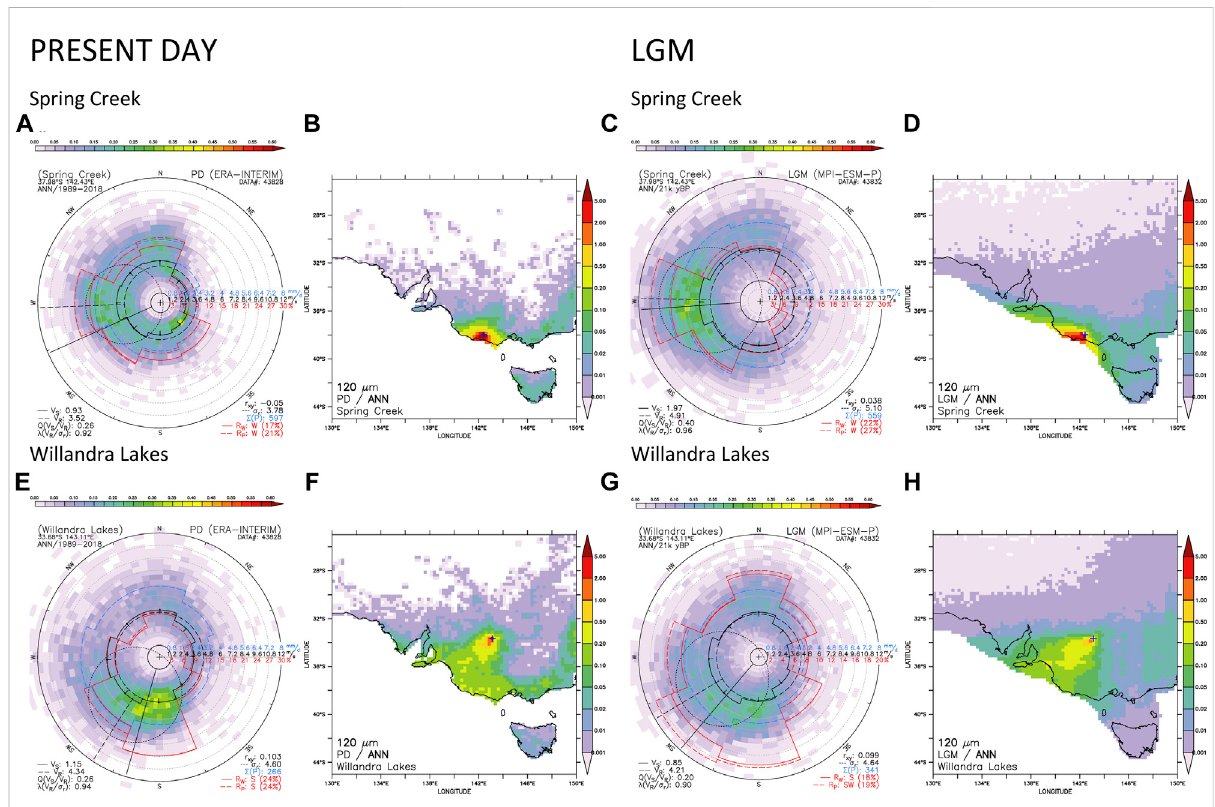
FIGURE 3 Wind regime analysis and simulated aeolian sources and transport statistics, and implications for air mass circulation in the PD and LGM. See Section2.4 andSupplementaryFigures fordetailed descriptionoftabled parameters.Color scalesshowrelativecontribution totheannualtotalsata given site. (A) Annual wind direction-strength occurrence histogram for the PD at Spring Creek. (B) Modelled source footprint of mobilized dust transport of 120 μ m particles to Spring Creek in the PD. (C,D) Results for the LGM conditions at Spring Creek. (E,F) Results for the PD at the WillandraLakes. (G,H) ResultsfortheLGMconditionsattheWillandraLakes. (I) PDcirculationofmajorairmassesSm(southernmaritime;westerlies) and sTc (subtropical continental; northerlies) to southeastern Australia (after Tapper and Hurry, 1993). (J) Proposed circulation to southeastern Australia during the LGM based on our simulations, indicating stronger and northward migration of westerly air fl ow over the